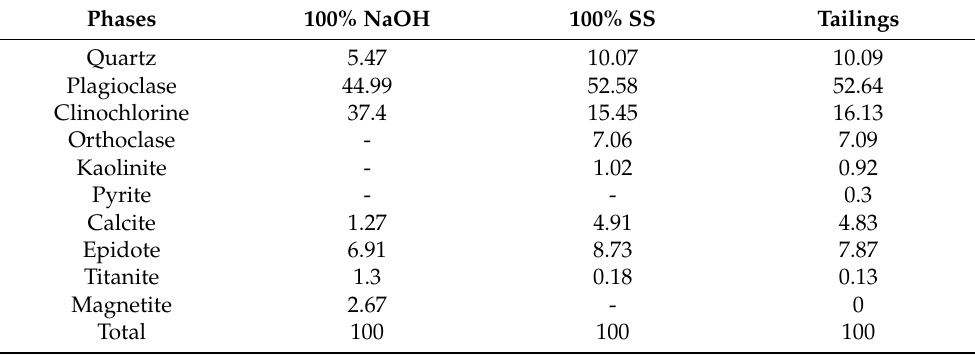
Table 7. Phases present in the tailings and created geopolymers according to XRD testing.